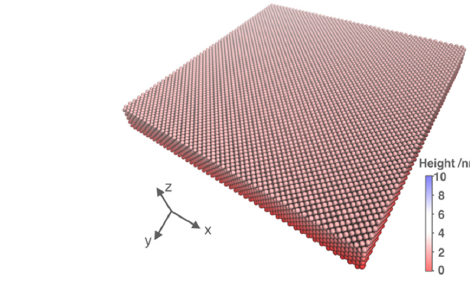
( c ) Λ = 11.328 nm (48 grid lengths) ( d ) Λ = ∞ nm (flat) Figure 3. Examples of four (a-d) sinusoidal surfaces with a 4-nm amplitude and wavelength ( Λ ) from 1.416 nm to infinity. These surfaces have the same base area as the surface in Figure 2b. The wavelength range includes the wavelengths of Figure 2b characterized using Fourier transform. The color of the beads indicates their elevations (in nm) in the z -direction. Other examples are provided in the Supplementary Material.